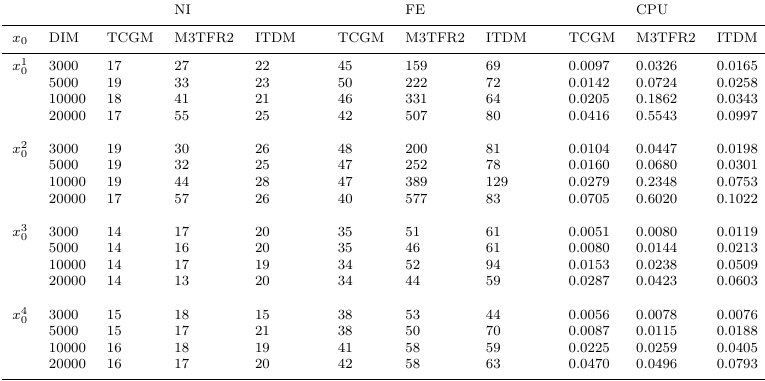
Table 5. Numerical results of Problem 5.